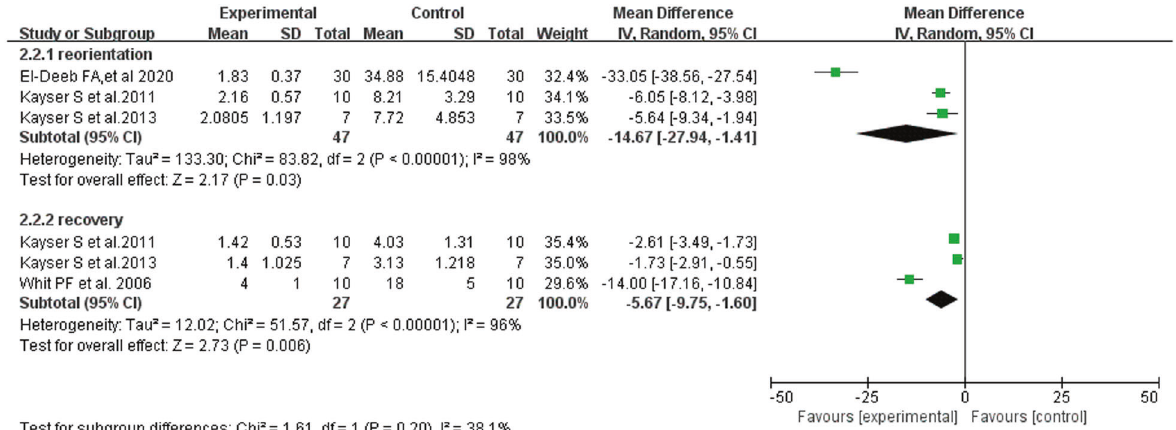
Fig. 4 Forest plot of reorientation and recovery time of MST antidepressant treatment.